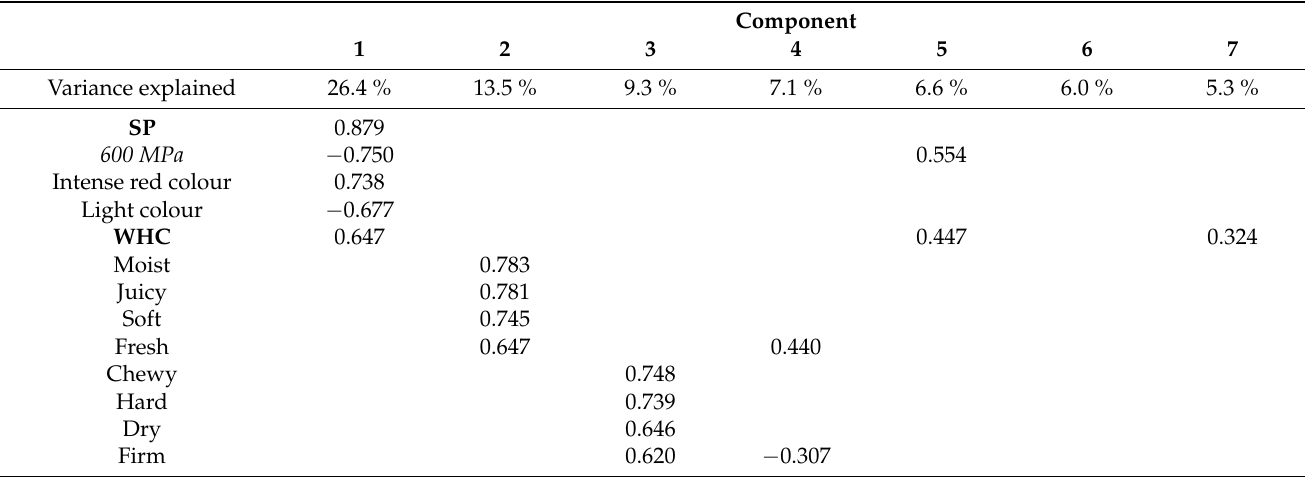
Table 4. Rotated component matrix from the Principal Component Analysis (PCA) on sensory characteristics, applied pressure treatment, amount of soluble protein per g of muscle sample (SP), and water-holding capacity (WHC) of cold smoked rainbow trout samples. Loadings < 0.3 are hidden from the table. Pressures are written in italics, physical parameters are written in